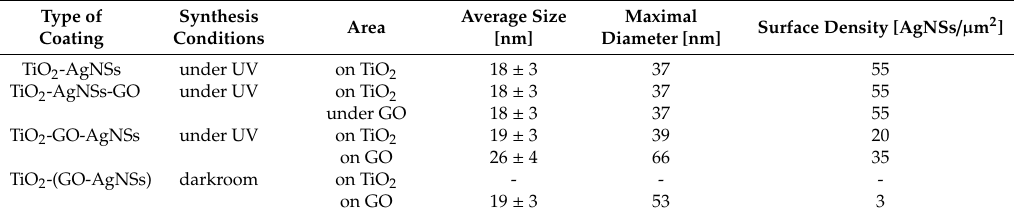
Table 1. Average size, maximal diameter and surface density of obtained AgNSs on specific areas of prepared